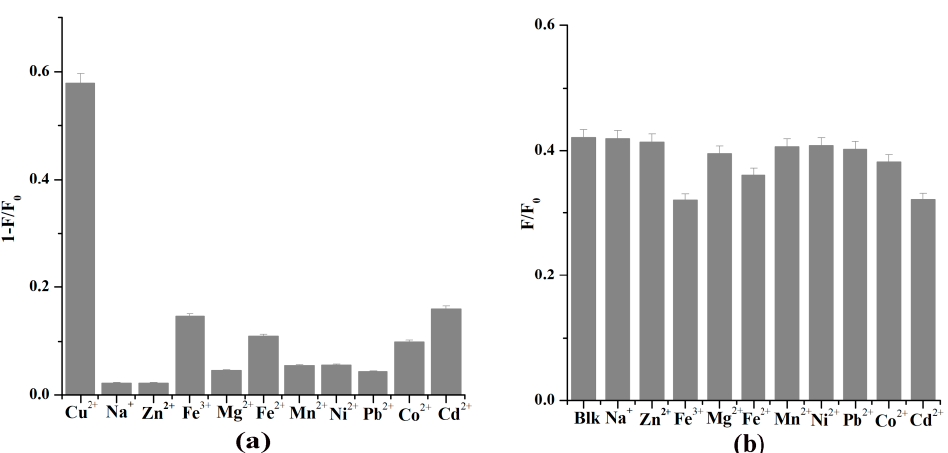
Figure 6. ( a ) FL intensity changes ( F / F 0 ) of FCDs upon addition of various metal ions (10 μ M). ( b ) The effect of coexisting metal ions (10 μ M) on selective sensing of Cu 2+ by FCDs (Blk is only 10 μ M Cu 2+ , λ ex = 320 nm, λ em = 452 nm).